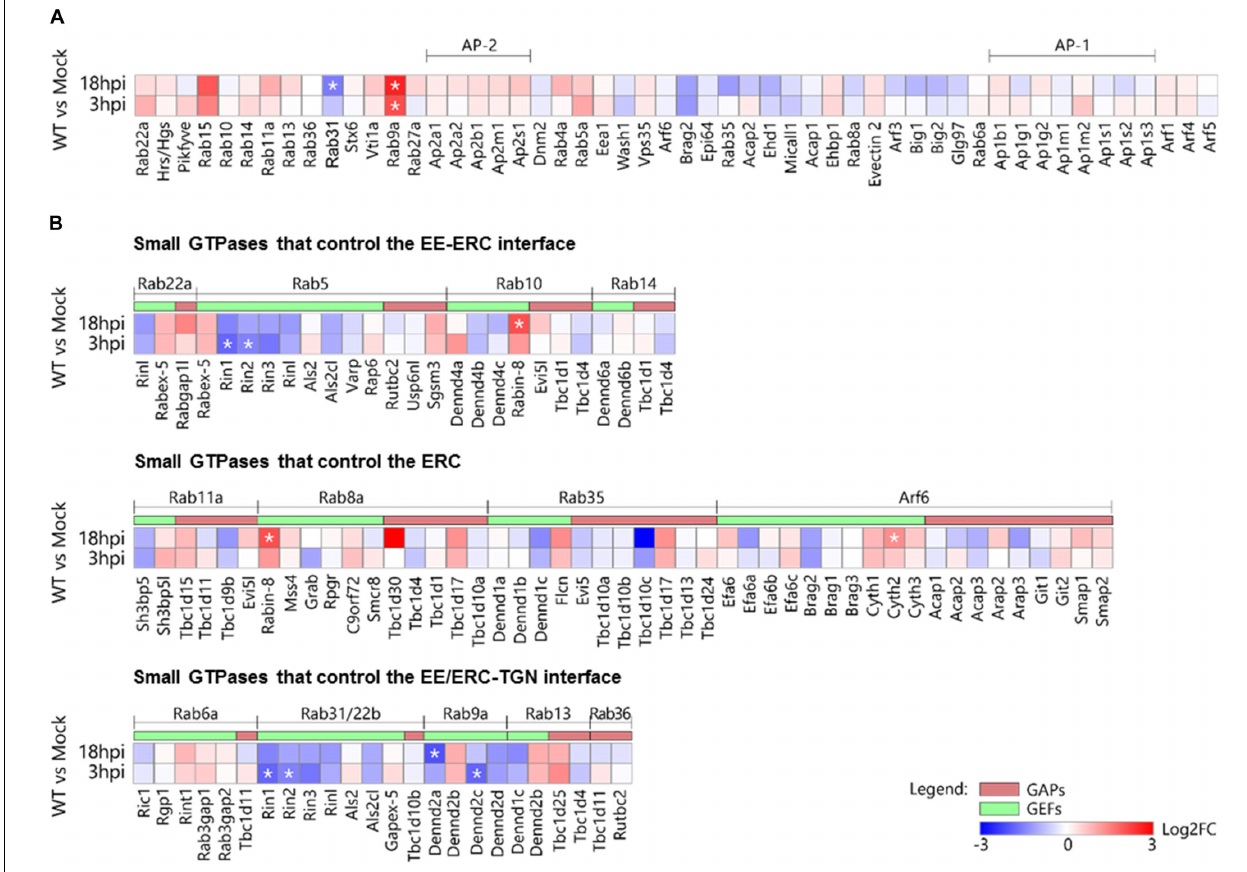
FIGURE 9 | Effect of MCMV infection on the expression of the genes encoding membranous organelle markers and regulatory proteins (GEFs and GAPs) that control membrane flow at the EE-ERC-TGN interface. (A) Genes encoding type B and C markers. (B) Genes encoding GEFs and GAPs that regulate small GTPases at the EE-ERC-TGN interface. The data represent the fold change (log2) of gene expression at the beginning (3 hpi) and the end (18 hpi) of the early phase of MCMV infection relative to the mock-infected cells. Statistically significant genes are designated with an asterisk (*). 2-column fitting